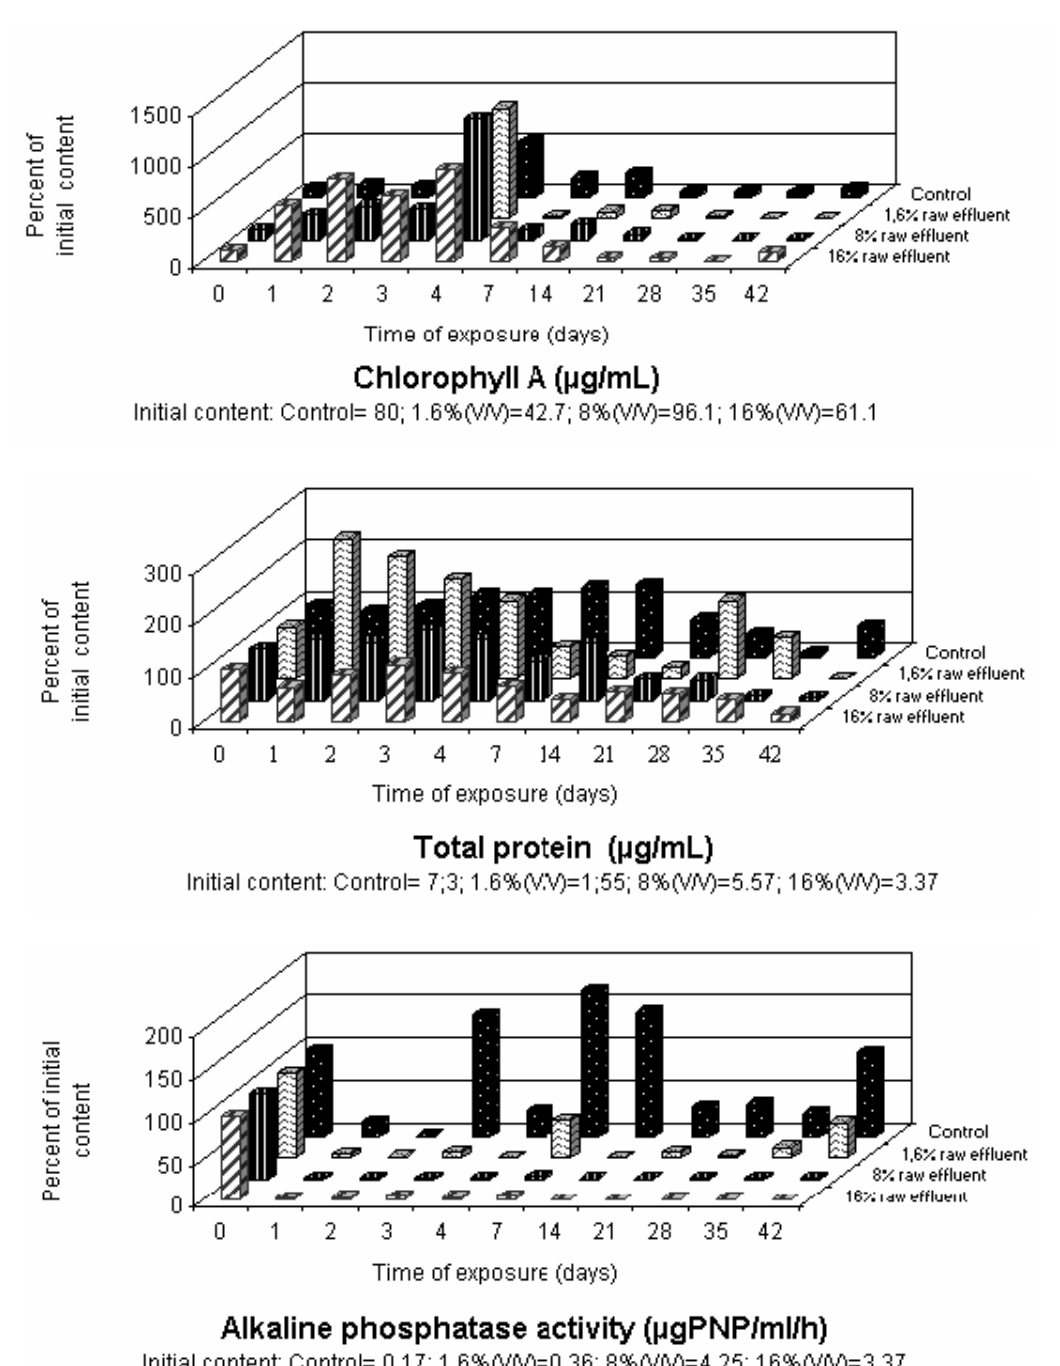
Figure 1 : The effect of Pilcam effluent on the chlorophyll A, microbial biomass (protein) content and alkaline phosphatase activity of untreated and treated microcosms. Significant effluent levels can be found in table